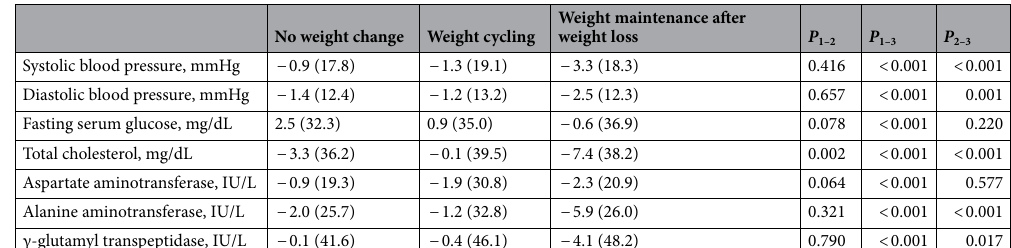
No weight change Weight cycling